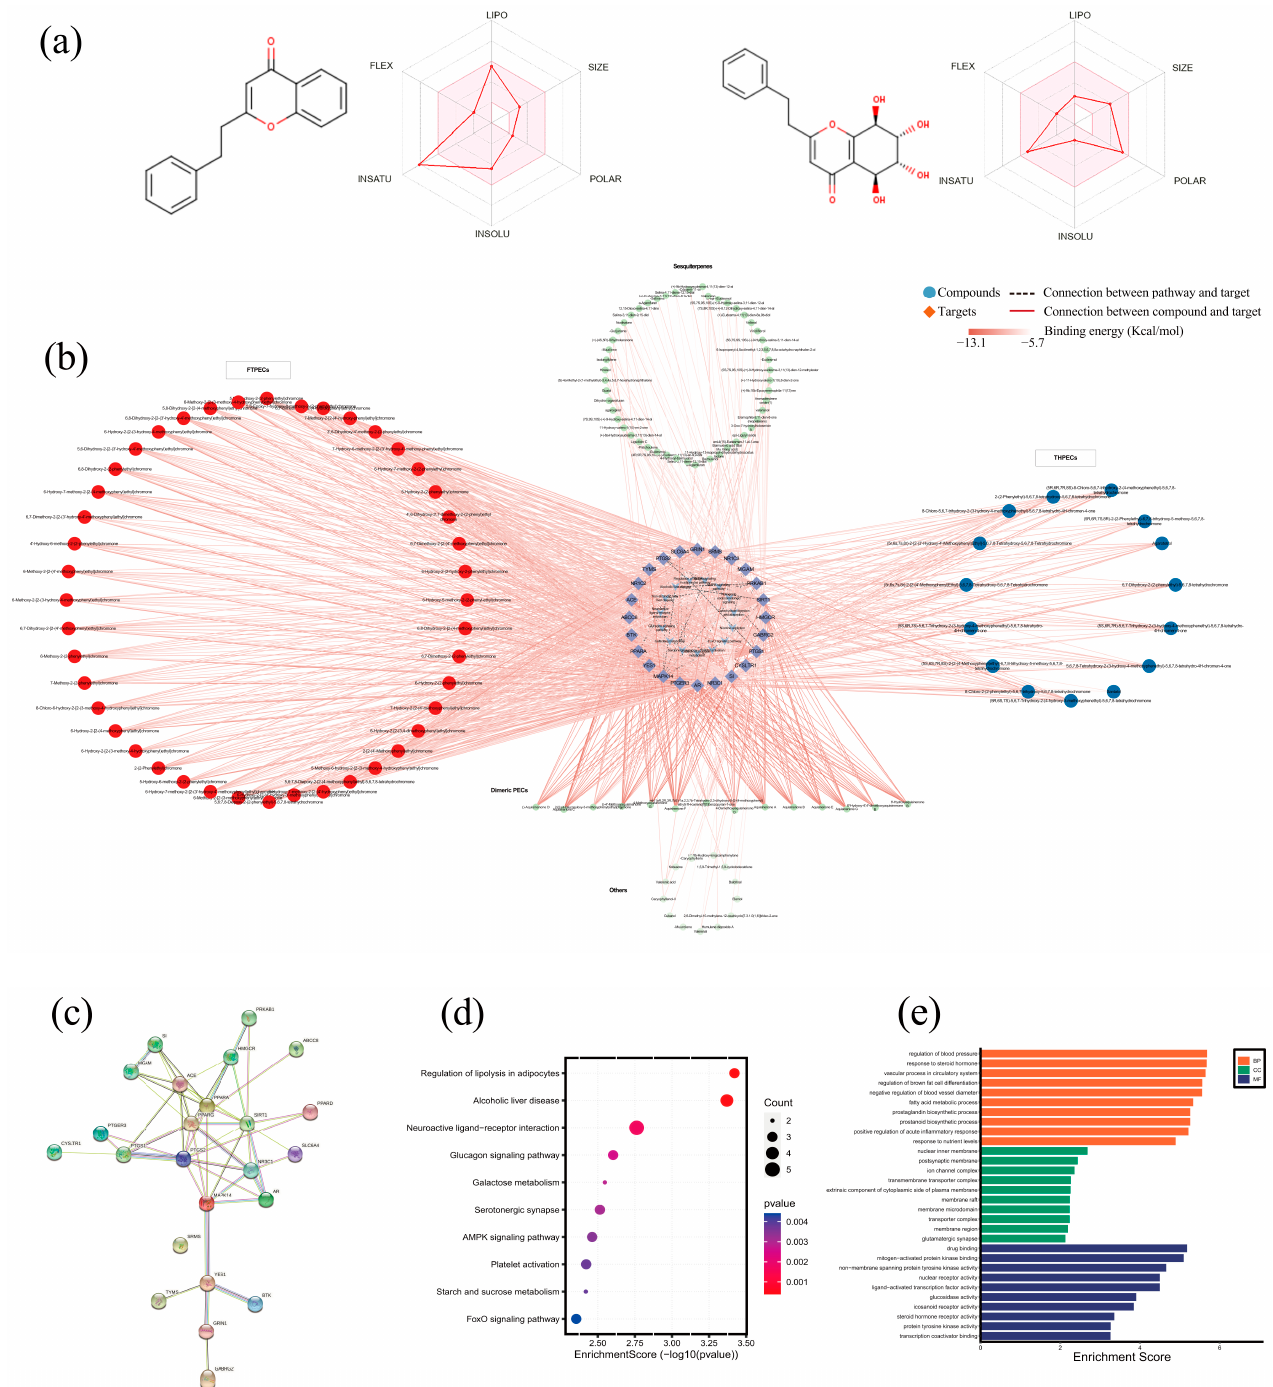
Figure 7. Molecular docking revealed the potential signaling pathways regulated by agarwood related to diseases. The predicted bioavailability radar of 2-(2-phenylethyl) chromone and agarotetrol ( a ), Simulation of a potential target-compound-pathway docking network visualized by Cytoscape ( b ). The depth of the red connecting line between the compound and the target gene represents the result of the free energy of molecular docking. Protein ‒ protein interactions (PPI) of potential targets ( c ), the bubble plot of KEGG pathway enrichment analysis ( d ), and GO analysis of potential targets with top 10 terms displayed in Bar graph ( e ). AMPK was selected to validate the bioactivity of GKA and normal agarwood. West- ern blot analysis confirmed that at a very low concentration of 30 µg/mL, both agarwood